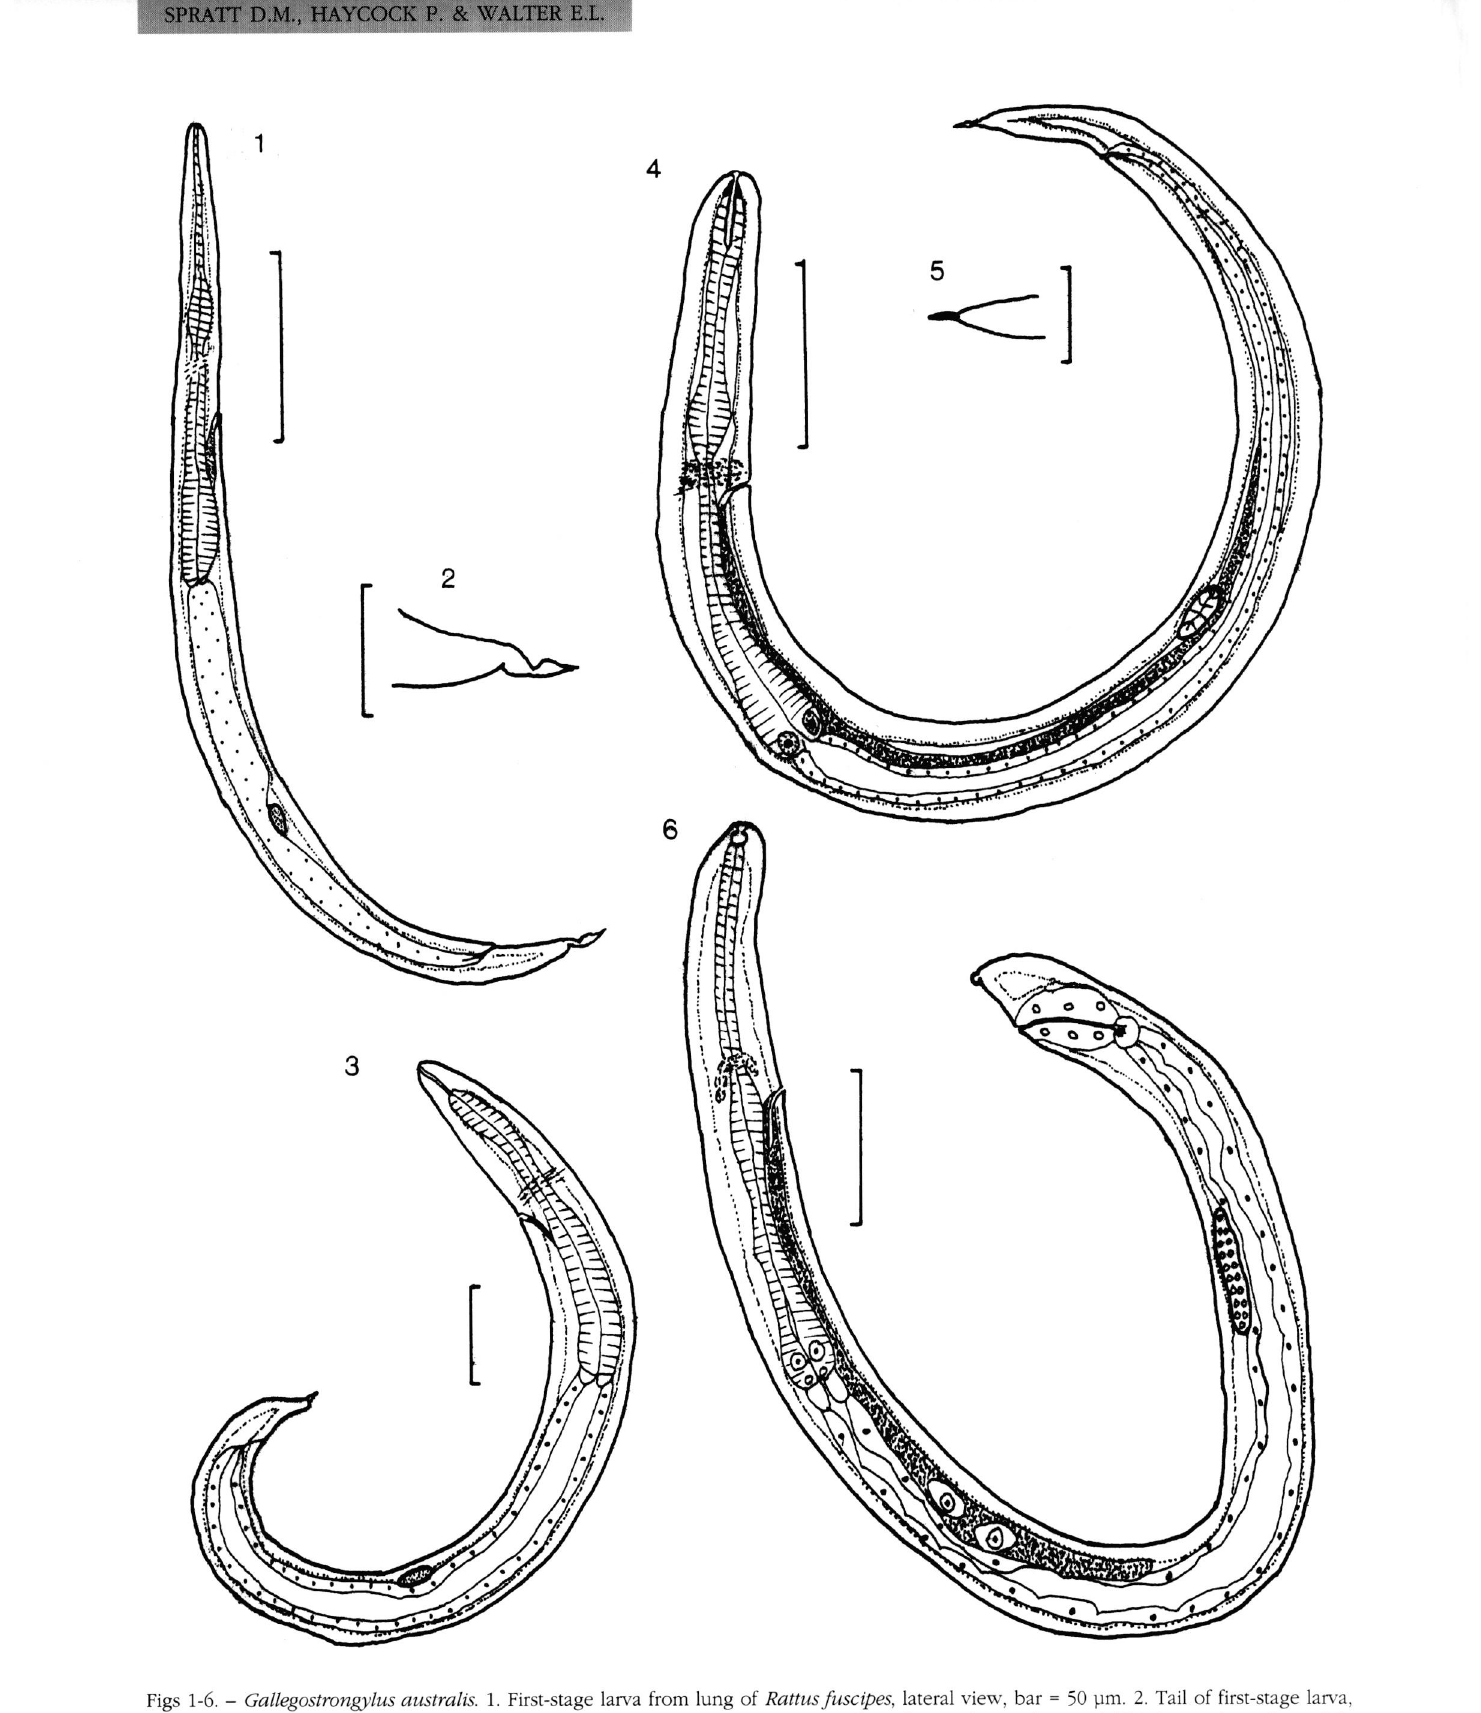
Figs 1-6. - Gallegostrongylus australis. 1. First-stage larva from lung of Rattus fuscipes, lateral view, bar = 50 pm. 2. Tail of first-stage larva, lateral view, bar = 10 pm. 3. Second-stage larva from Deroceras panormitanum, lateral view, bar = 40 pm. 4. Third-stage larva from Leh- mannia flava, lateral view, bar = 50 pm. 5. Tail of third-stage larva, lateral view, bar = 10 pm. 6. Fourth-stage larva from lung of Rattus fuscipes, lateral view, bar = 50